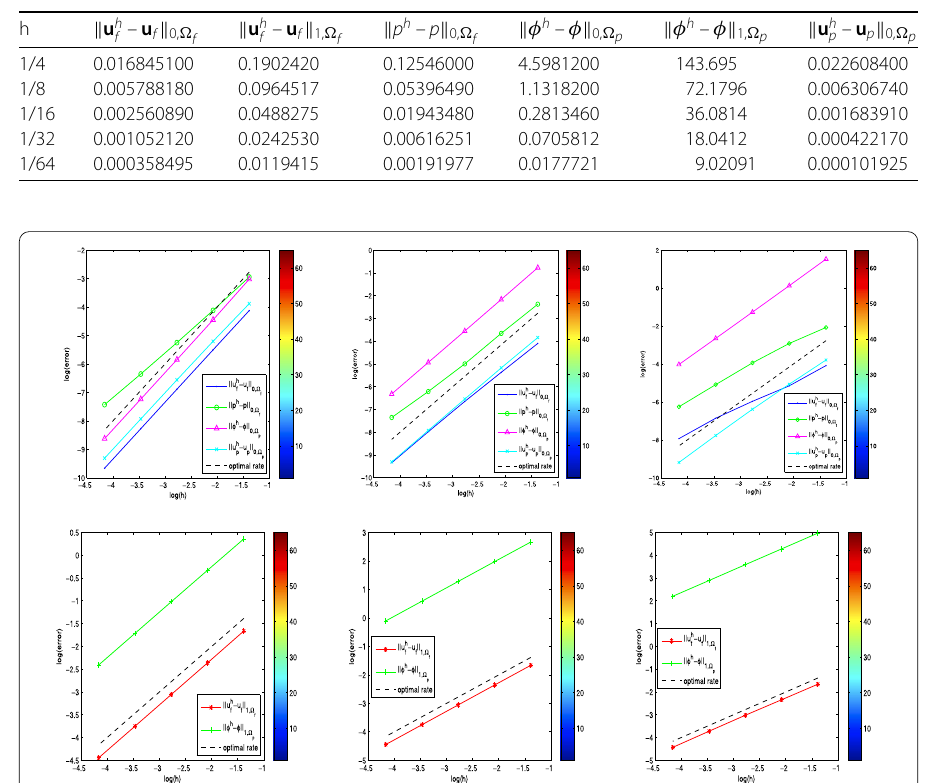
Figure 6 The order of convergence for stabilized finite element scheme using changing mesh for test 2: the error order of L 2 -norm for K = 0.1 I (top-left), K = 0.01 I (top-middle), K = 0.001 I (top-right); the error order of H 1 -norm for K = 0.1 I (down-left), K = 0.01 I (down-middle), K = 0.001 I (down-right)